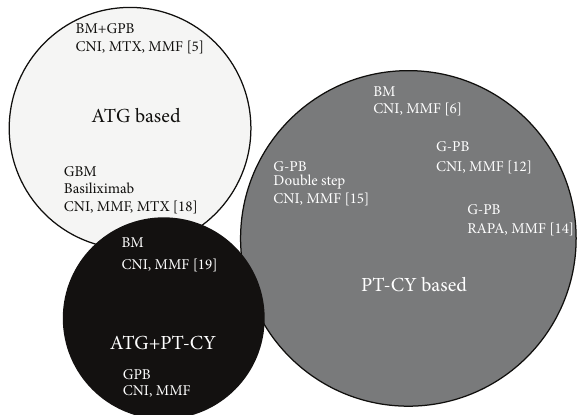
Figure 1: Different platforms of GvHD prophylaxis for patients undergoing a haploidentical stem cell transplant. ATG: programs based on antithymocyte globulin (ATG) include the original Chinese protocol [5] using bone marrow (BM) + G-mobilized peripheral blood (G-PG) and cyclosporin (CsA), mycophenolate (MMF), and methotrexate(MTX).AlsoitincludesthemodifiedG-mobilizedBM (G-BM) + CsA + MMF + MTX + basiliximab [18]. PT-CY: programs based on posttransplant cyclophosphamide (PT-CY) . The original Baltimore protocol [6], with unmanipulated BM, a calcineurin inhibitor (CNI), and MMF. The modified program with rapamycin and G-PB [12] and the double step approach [14] ATG + PT-CY. The combined use of ATG + PT-CY as proposed by the Baltimore group in sickle cell disease [19], or by the French cooperative group using G-PB as a stem cell source